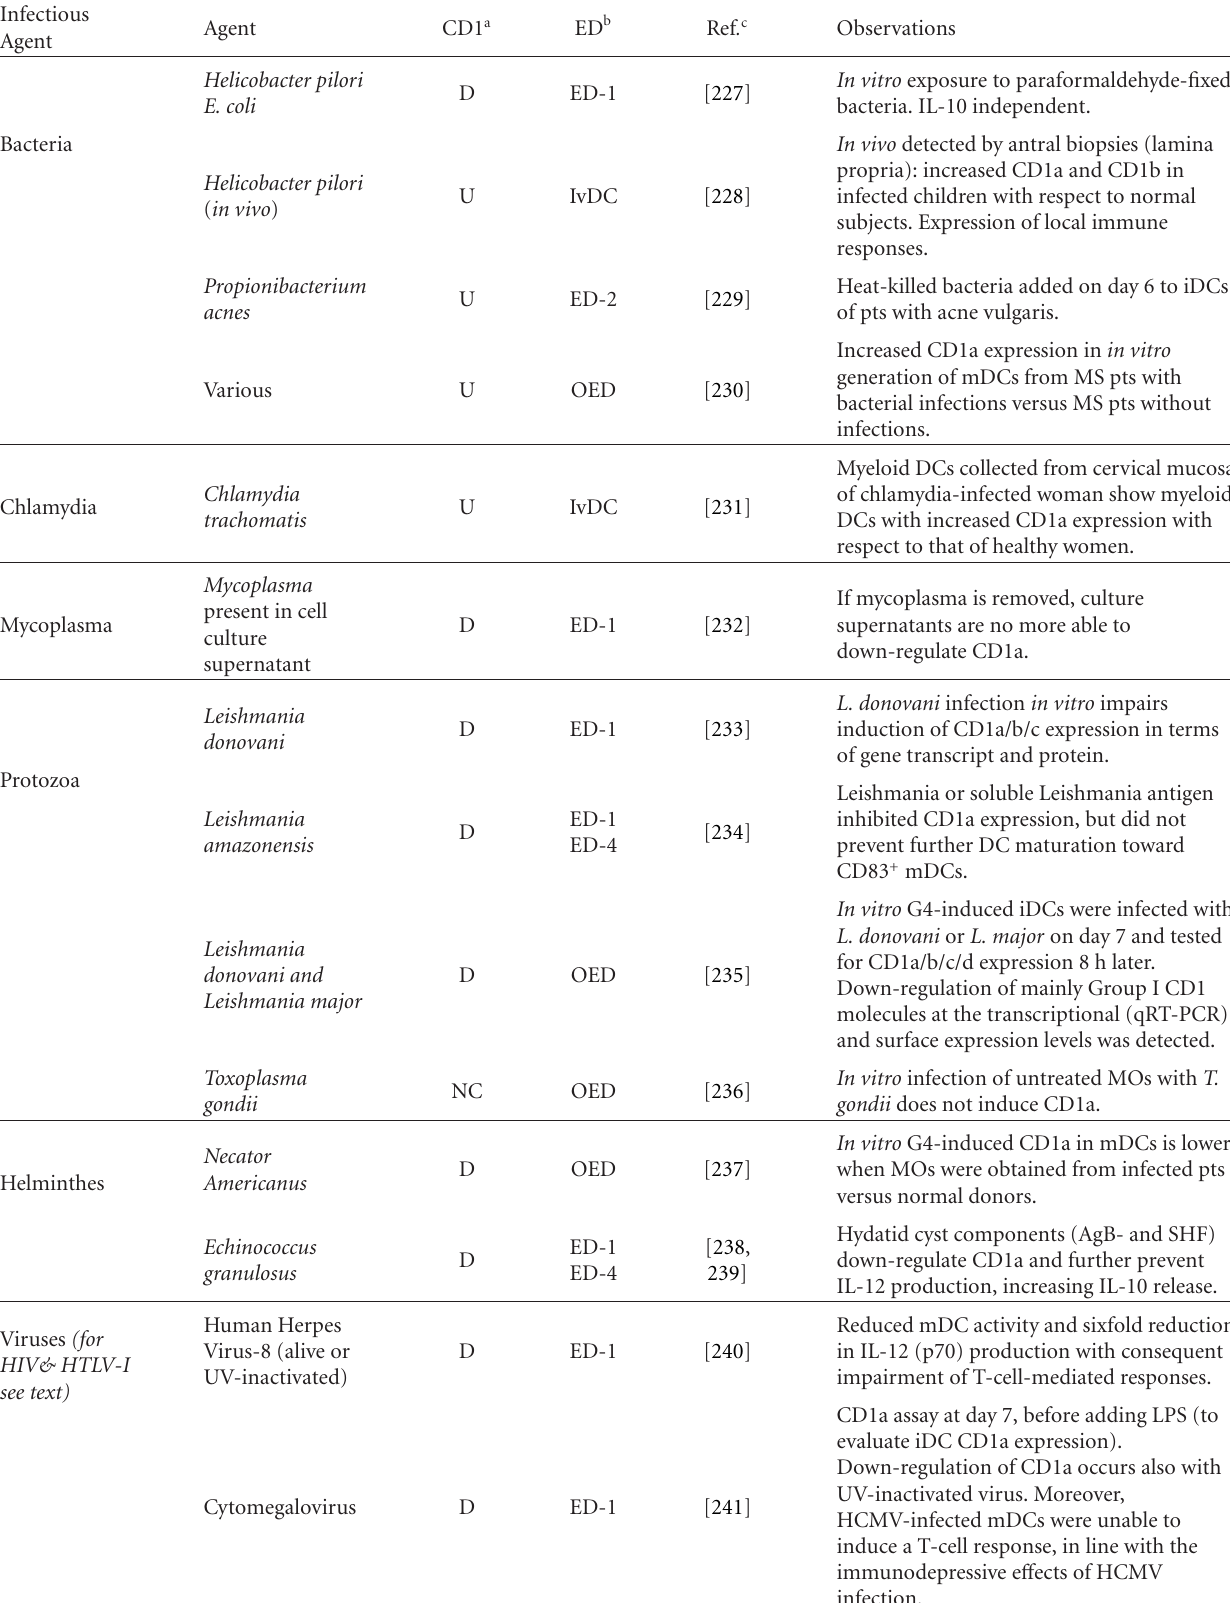
Table 5: Influence exerted by infectious agents or microorganism products on group 1 CD1 antigen expression.